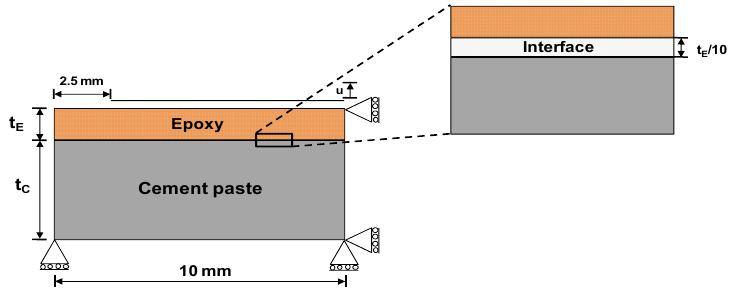
Figure 3. Schematic of the FE model for the pull ‐ off adhesion test. Where t E = 0.350 mm, t C = 1.75